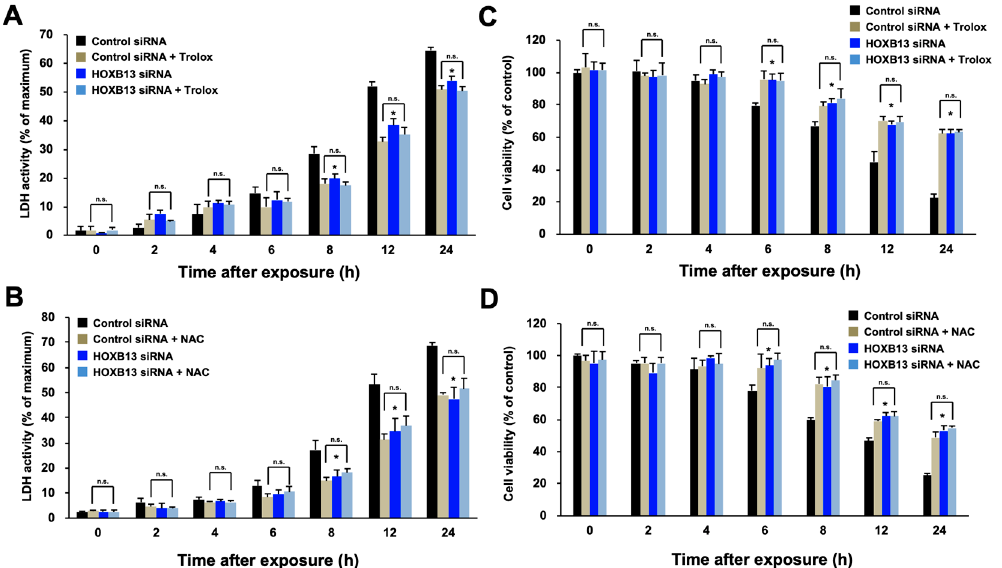
Figure 1. Effects of HOXB13 knockdown and antioxidants on cytotoxicity caused by hydrogen peroxide. A549 cells were transfected with control siRNA or HOXB13 siRNA for 24 h and then the cells were re-seeded onto 48-well plates and incubated for 24 h. Cells were exposed for the indicated period to hydrogen peroxide (400 µM) and Trolox (10 µM; A , C ) or NAC (100 µM; B , D ). Cell death was measured by LDH assay ( A , B ) or alamarBlue assay ( C , D ). All values are mean ± S.D. of three individual experiments. * p < 0.05 vs. Control siRNA. n.s. indicates not significant.